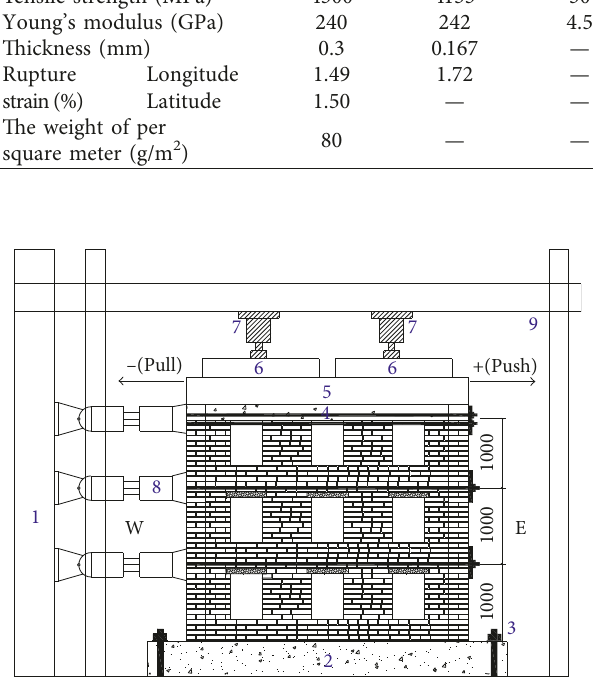
Figure 3: Test setup: (1) reaction wall, (2) RC bottom beam, (3) threaded rods, (4) RC head beam, (5) loading beam, (6) distribution beam, (7) load jacks, (8) MTS actuators, and (9) loading frame.